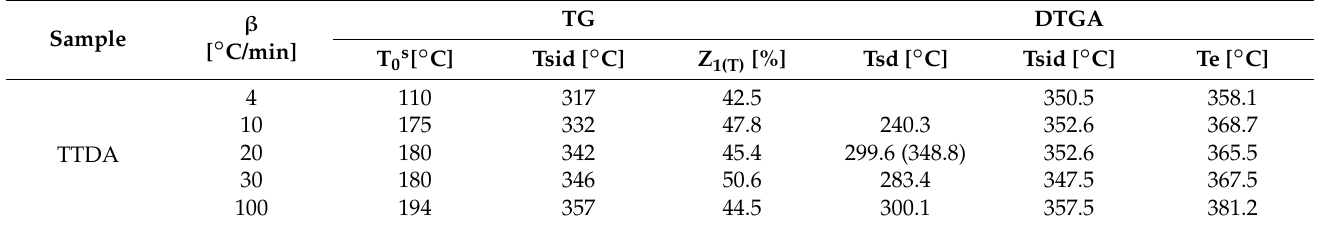
Figure 5. Thermograms of a DNTT sample with a separate stage of gas-phase decomposition ( a ) (heating rate 1 and 2.5 min −1 ) and solid-phase decomposition with gas-phase assisted ( b ) (heating rates 4 and 10 min −1 ). Table 5. Decomposition points of samples according to DTA data. Table 5. Decomposition points of samples according to gravimetry data II exothermic